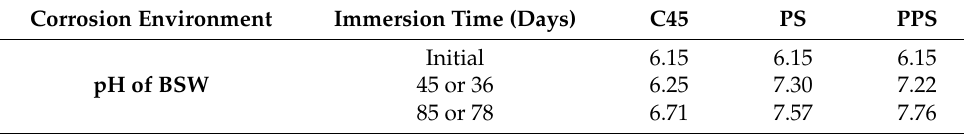
Table 3. Variation of the corrosion environment pH with the immersion time of the samples. Corrosion Environment Immersion Time (Days) C45 pH of